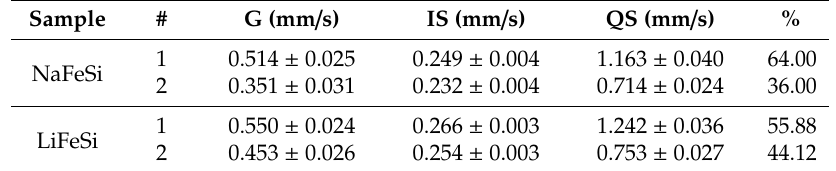
Table 1. Hyperfine parameters obtained from Mössbauer spectrum of the NaFeSi and LiFeSi samples.